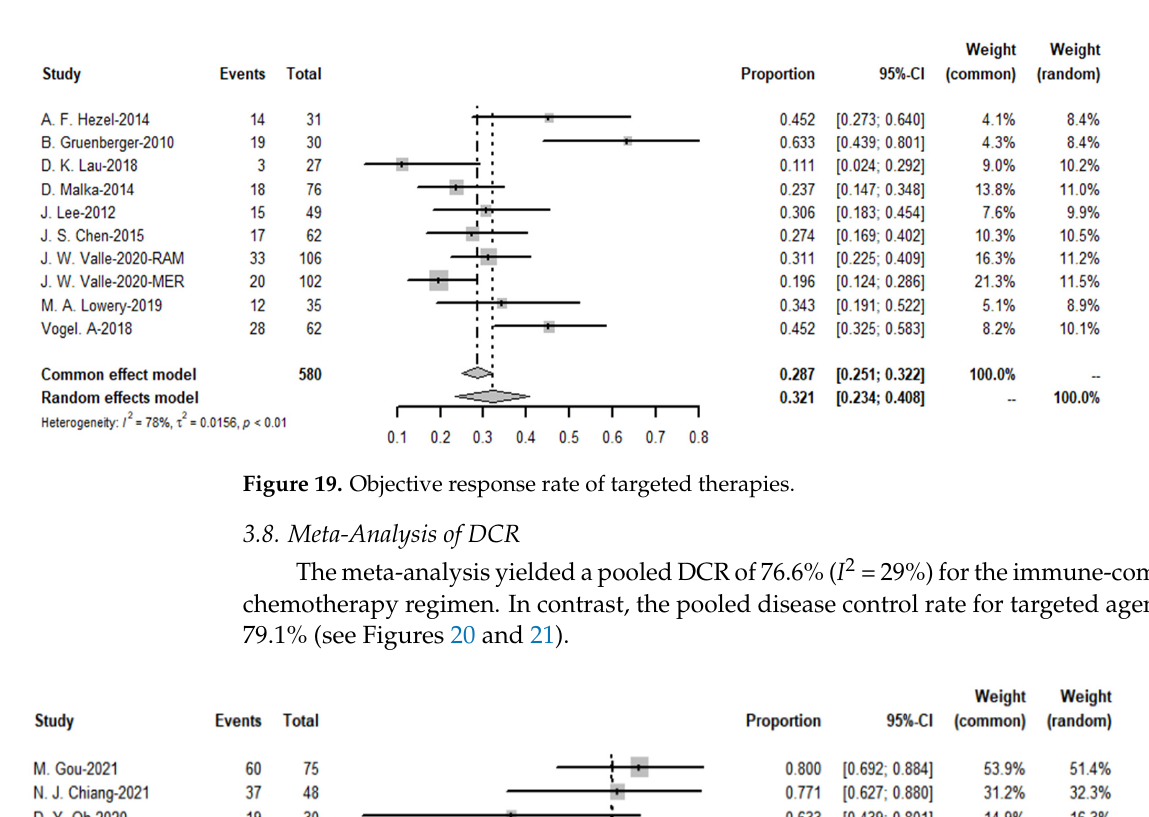
Figure 19. Objective response rate of targeted therapies.